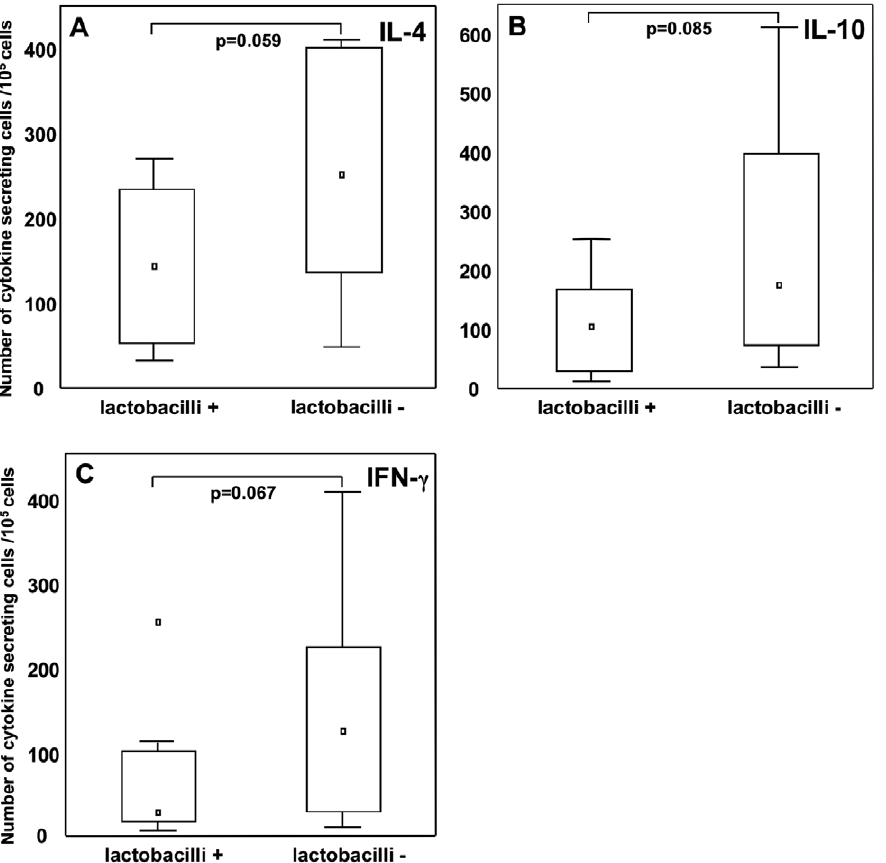
Figure 1. Lactobacilli colonization at 2 weeks of age in relation to cytokine secreting cells, after invitro PHA stimulation at age two. Infants with (n=9) or without (n=18) lactobacilli at 2 weeks of age in relation to (A) IL-4 2 , (B) IL-10 2 and (C) IFN- c producing cells after PHA stimulation. Boxes cover 25 th to 75 th percentile and the central square being the median value. Whiskers extend to non-outlier maximum and minimum and squares represents outliers.